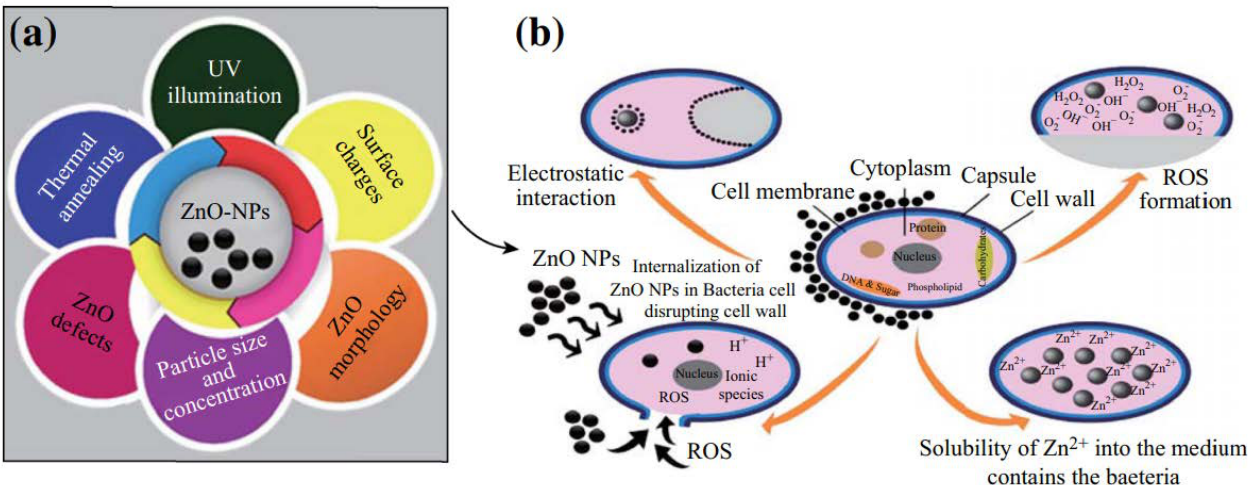
Figure 1. ( a ) An impact of key ZnO NPs parameters on the antibacterial response and ( b ) correlation between the several potential mechanisms of ZnO NPs antibacterial activity, such as ROS produc-